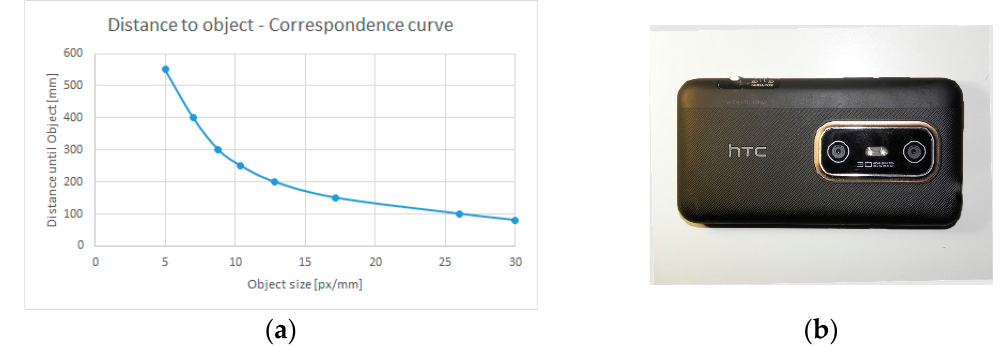
Figure 5. Correspondence curve between object size and distance to object for low-cost cameras. ( a ) Calibration curve fit; ( b ) low-cost cameras (authors’ mobile phones).